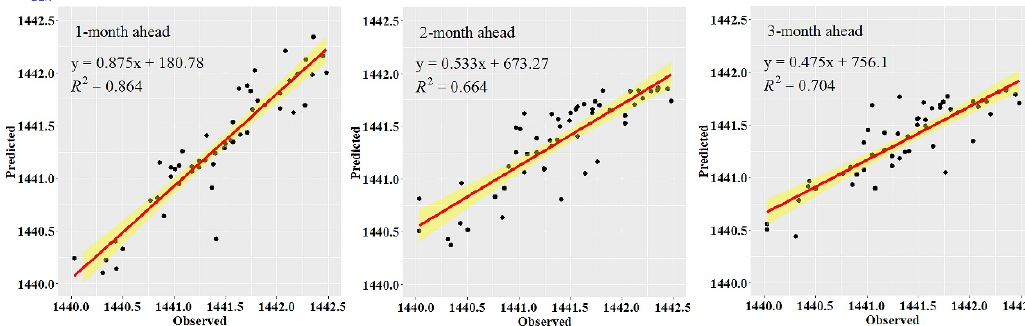
Figure 4. Scatter plot of the observed and predicted groundwater level for Well I generated by the CEEMDAN-GA-DBN, CEEMDAN-DBN and DBN models for 1-, 2- and 3-month ahead forecast in the testing period.